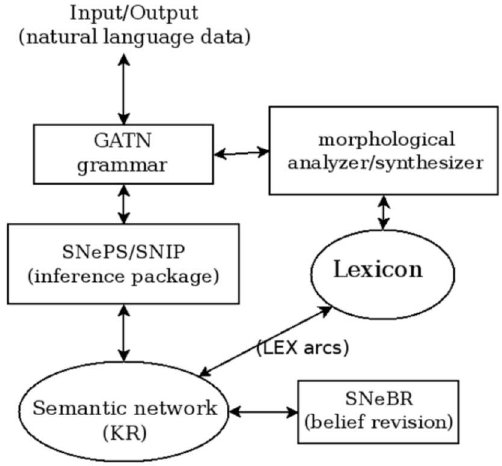
Figure 1. A schema of natural-language processing system implemented in SNePS/GLAiR cognitive